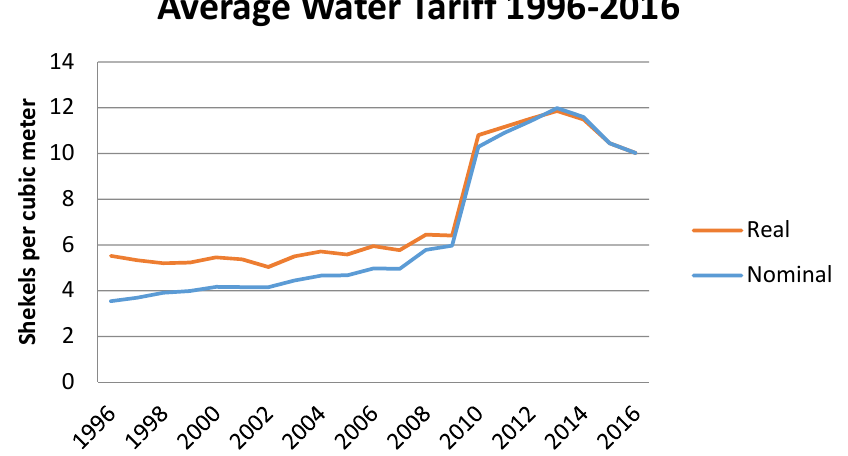
Figure 3. Average municipal water tariffs 1996–2016. Based on data from [43]. Real prices in 2016 shekels.